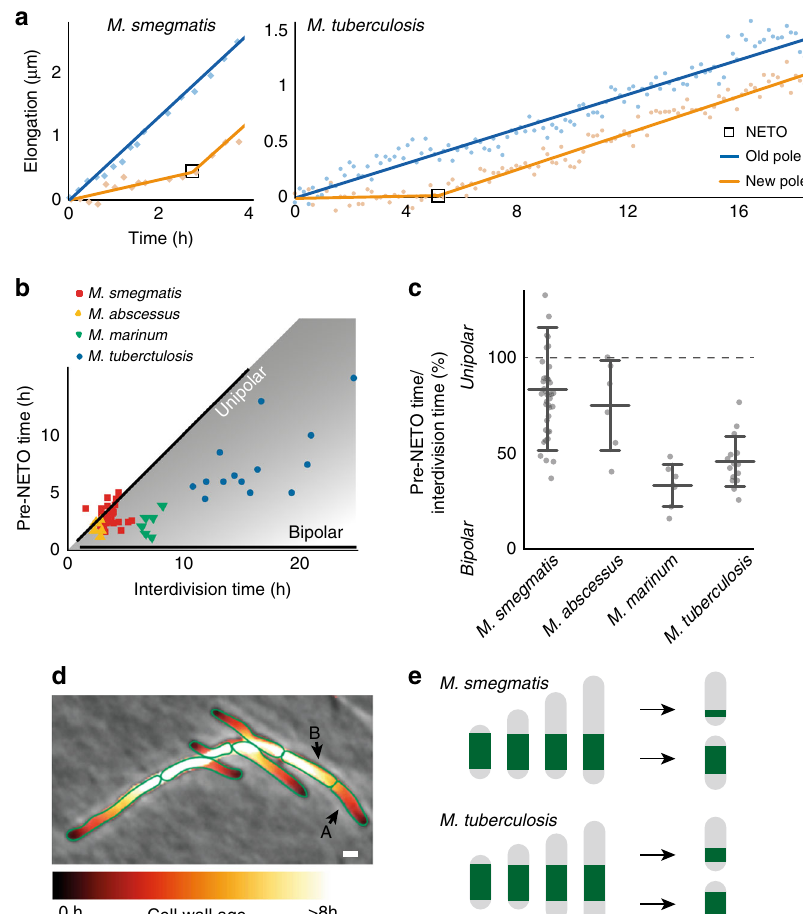
Fig. 6 Species-speci fi c NETO dynamics impart different patterns of asymmetry. a Elongation dynamics of representative old and new cell poles of M. smegmatis and M. tuberculosis between birth and division. Points: phase-contrast microscopy data. Lines: linear fi t (blue) or bilinear fi t (orange). b Pre-NETO phase vs. interdivision time in M. smegmatis (38 poles), M. tuberculosis (14 poles) , M. abscessus (6 poles), and M. marinum (6 poles). Each symbol represents a new cell pole. Black lines indicate the expected pre-NETO time and interdivision time corresponding to unipolar growth or bipolar growth. c Asymmetry of old pole and new pole growth between birth and division in individual cells of M. smegmatis , M. abscessus , M. marinum , and M. tuberculosis , expressed as the ratio (pre-NETO time)/(interdivision time). Bars indicate averages and standard deviations. d Calculated spatial pattern of cell wall age for individual cells within a microcolony of M. smegmatis based on time-lapse phase-contrast microscopy. e Calculation of the partitioning of cell wall material inherited by the daughter cells from the original mother cell in M. smegmatis (top) and M. tuberculosis (bottom), based on the average values calculated from the experimental data in c and assuming symmetric division for